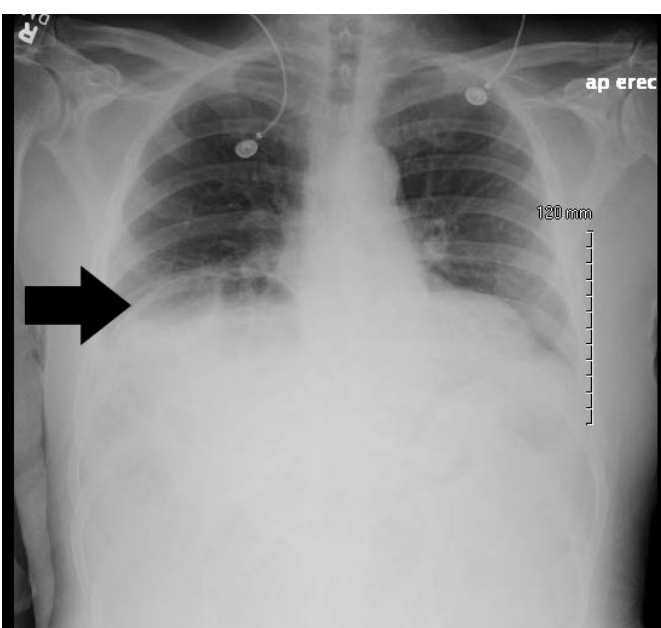
Figure. Upright chest radiograph demonstrating Chilaiditi sign (pseudopneumoperitoneum) mimicking apparent free intraperitoneal air under the right